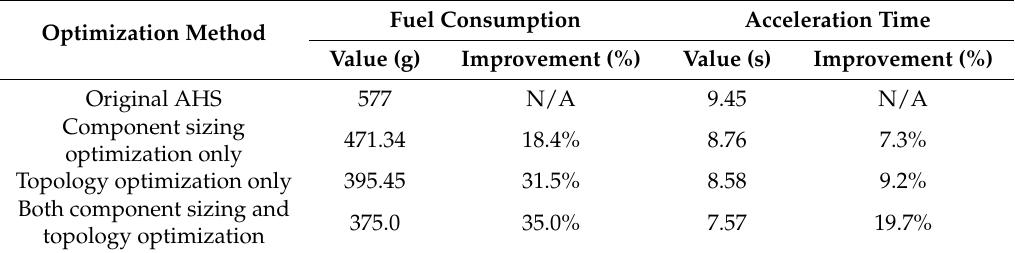
Figure 8. Results of nested optimization where red line is the Pareto ‐ optimal. Table 2. Performance improvement of the hybrid bus before and after nested optimization.